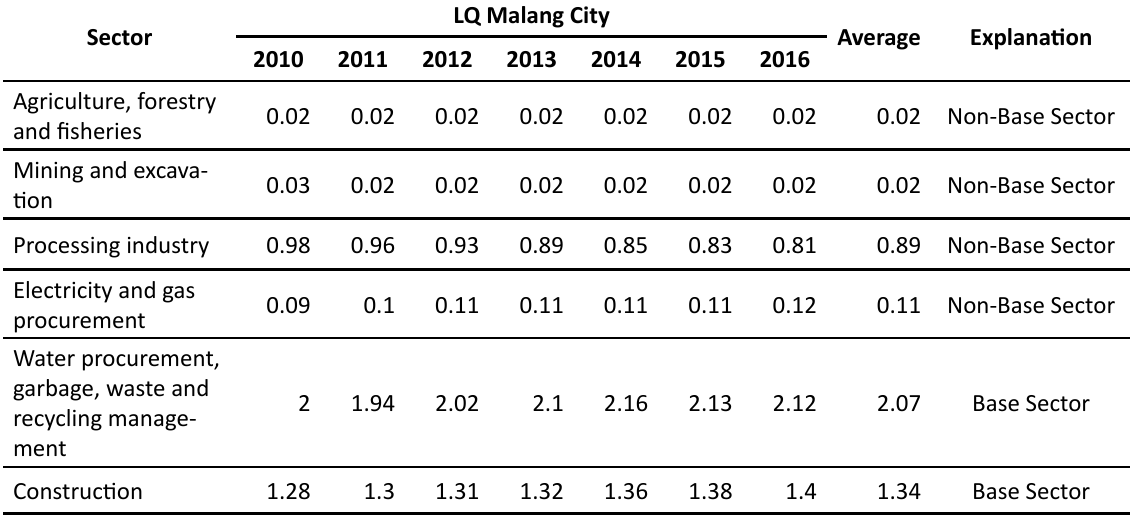
Table 2: Calculation Results of Location Quotient (LQ) in Malang City,